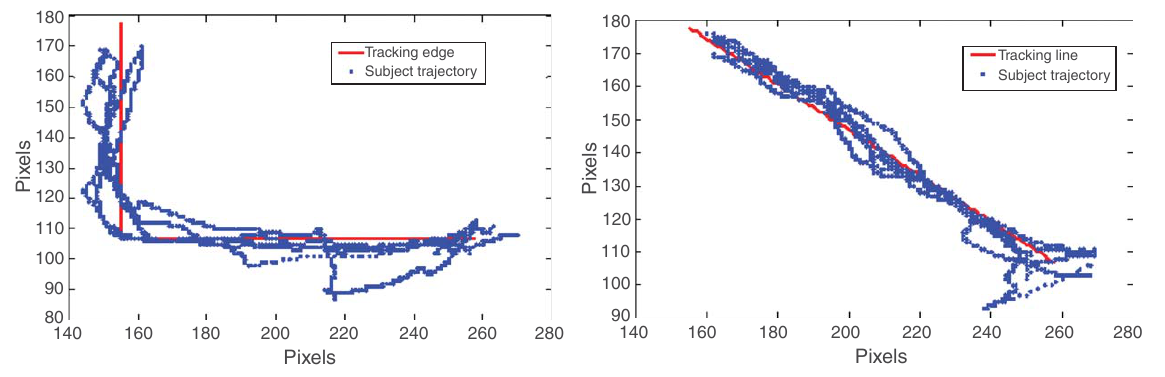
Fig. 7. Line and edge tracking performance of the muscle ataxia impaired